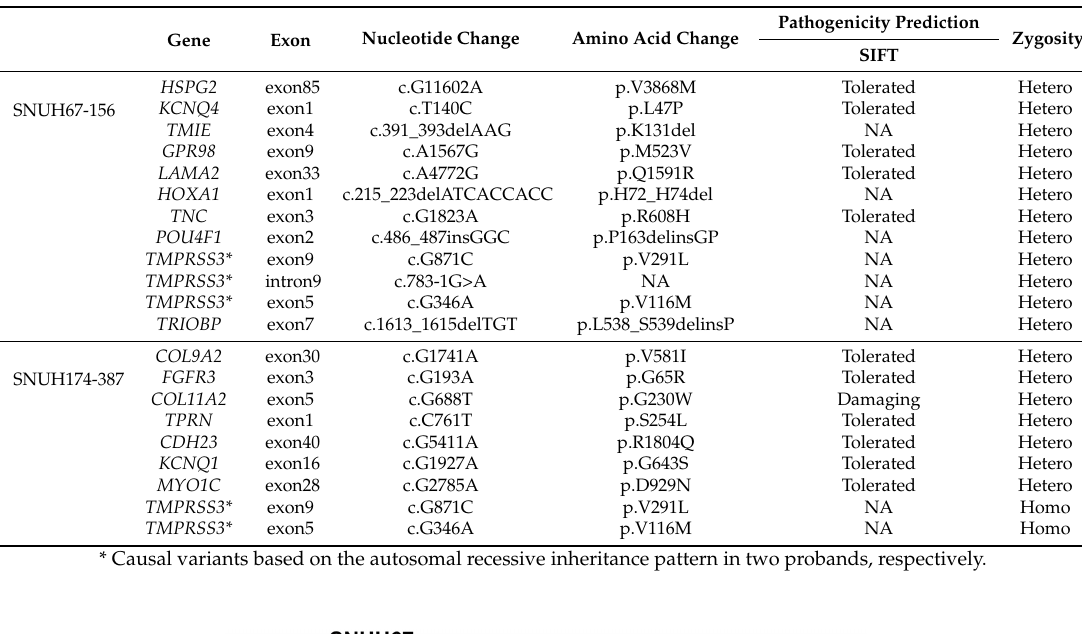
Table 1. List of the variants surviving from initial filtering based on the TRS200, TRS129 analysis. Details of final candidates after targeted re-sequencing of the 200, 129 deafness genes, respectively.